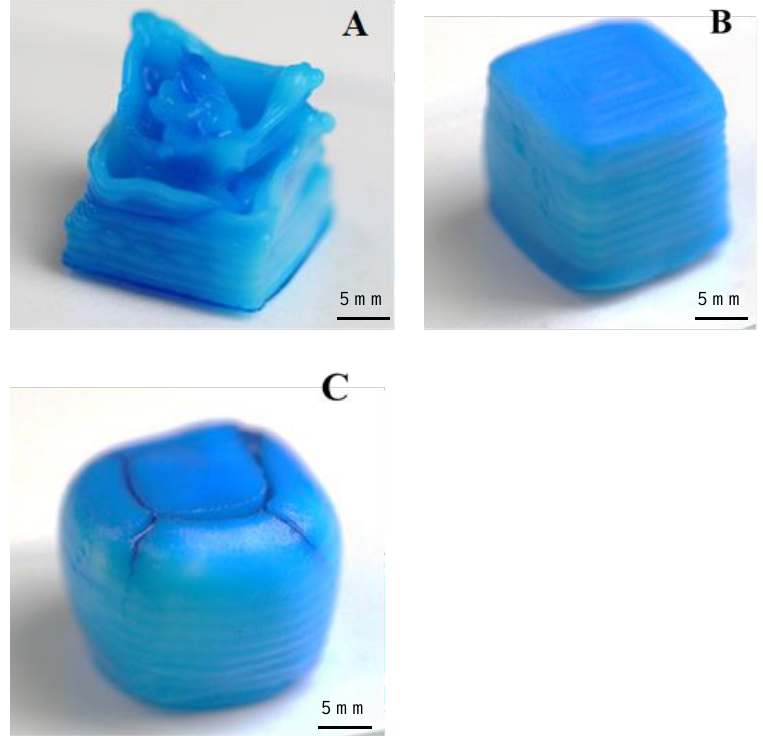
Figure 4. Examples of printed gel cubes with an approximate side length of 10 mm. Shown are a cube printed with insufficient extrusion of gel ( A ), overflowing amounts of extruded gel ( C ) and close to ideal print settings ( B ). Cubes have been dyed blue using food colouring for better contrast in the displayed photos. The best 3D printed gel cube should have a flat surface with the closest surface area to 10 mm 2 , corners of 90°, side view width of 10 mm, side view height of 10 mm. By changing the print settings, the printed samples top area varied between 156.09 mm 2 to 60.12 mm 2 (Table 2).